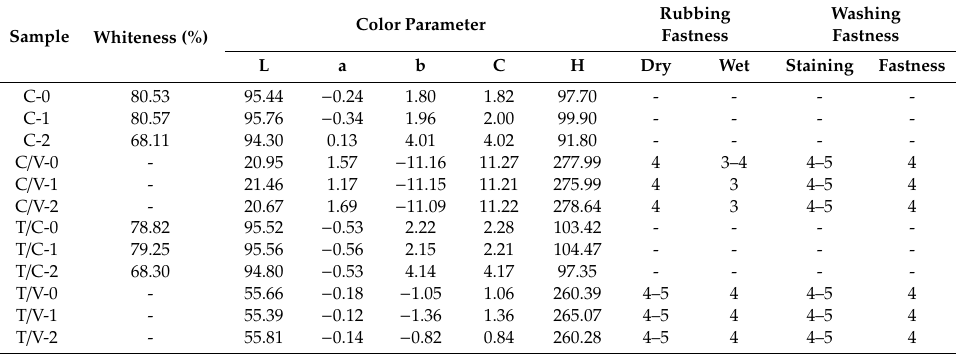
Table 5. Whiteness, color parameters and colorfastness of original and treated